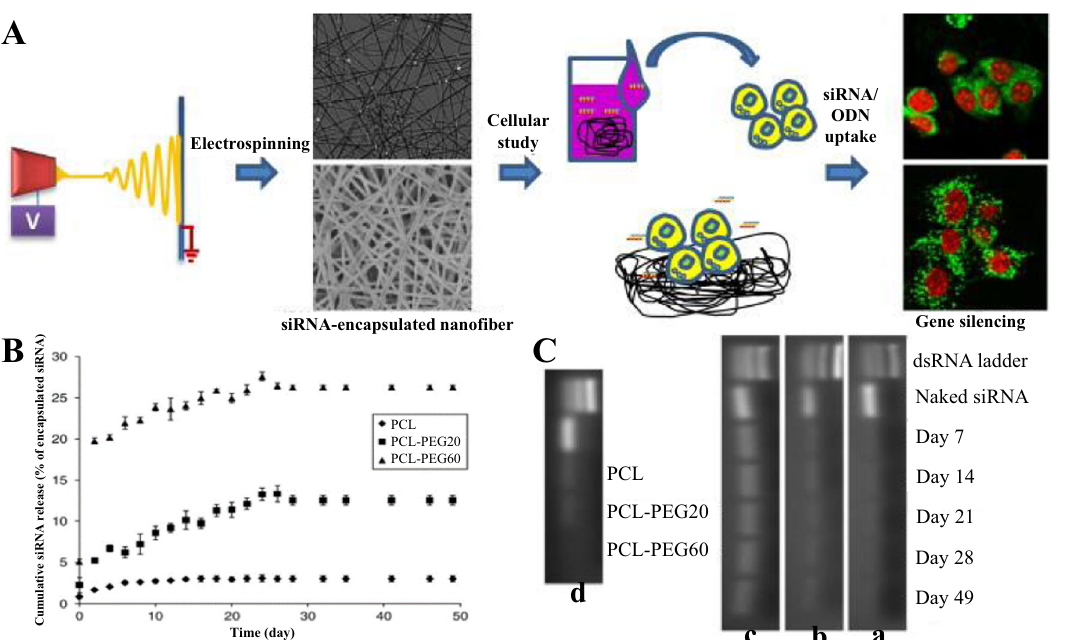
Fig. 3 Flow chart of siRNA experiments encapsulated in polycaprolactone nano fi bers ( A ), In vitro release test results ( B ), and analysis of siRNA integrity in polymeric nano fi bers ( C )